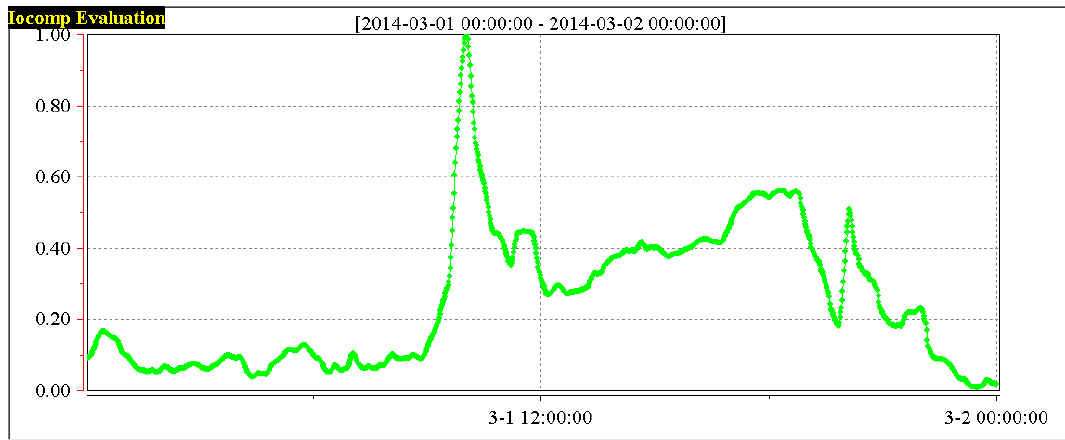
Figure 15. The boiler thermal efficiency x 1 (%) (2# boiler).